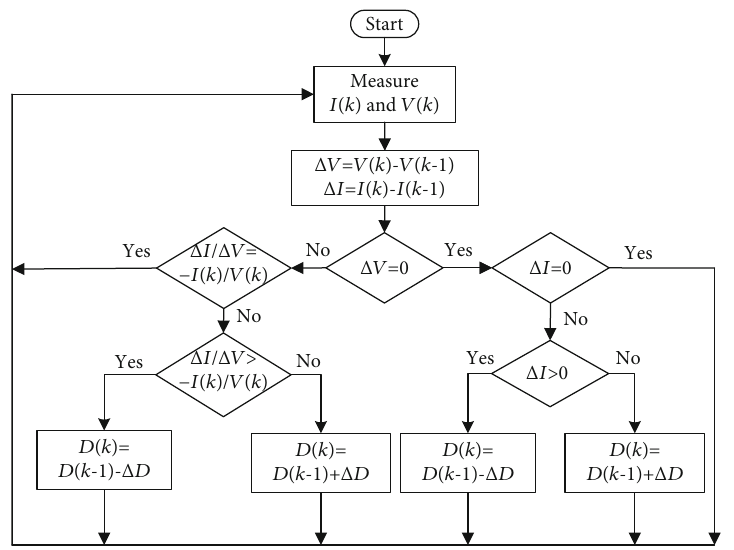
Figure 4: Flowchart of the conventional INC